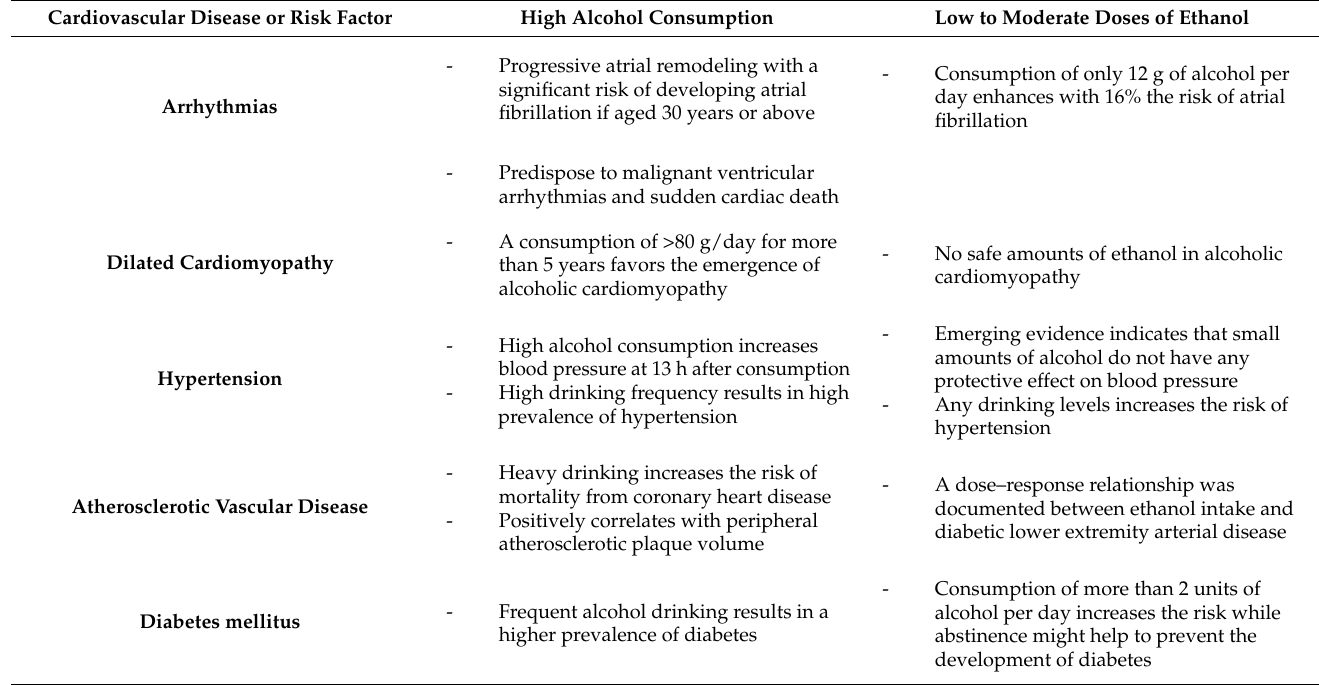
Table 1. The effects of high-dose ethanol versus low to moderate alcohol consumption on the above-considered diseases. Cardiovascular Disease or Risk